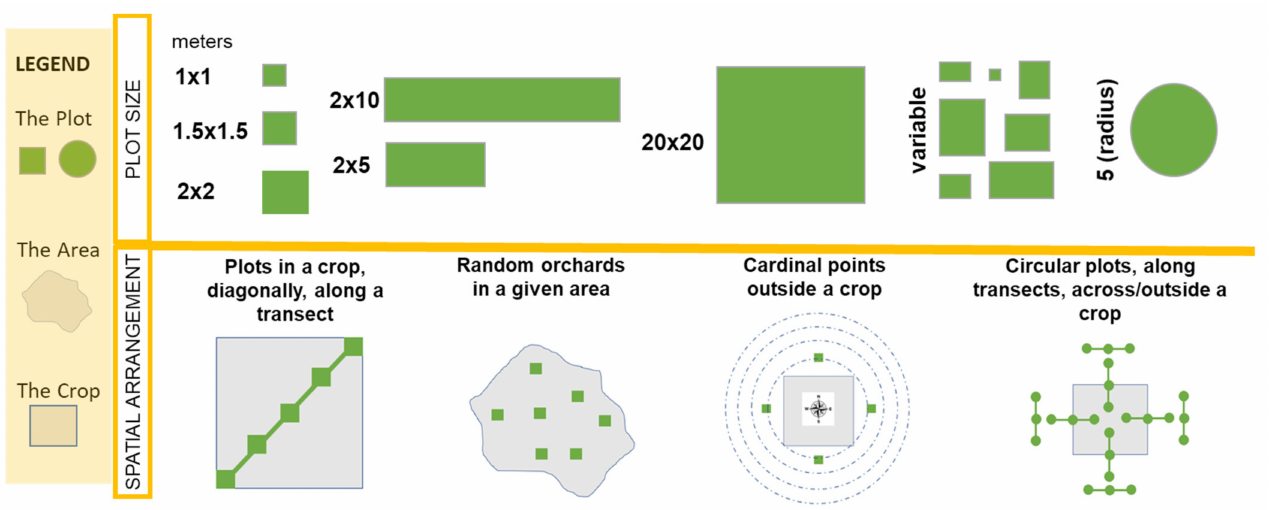
Figure 4. Plots: a space to describe vegetation. Complexity of plot size and spatial arrangements. Plot size coincided in some studies, e.g., 1 × 1 m [56,57]. Examples of plot arrangement were inspired by ( 1 ) [28]; ( 2 ) [56]; ( 3 ) [55]; ( 4 )